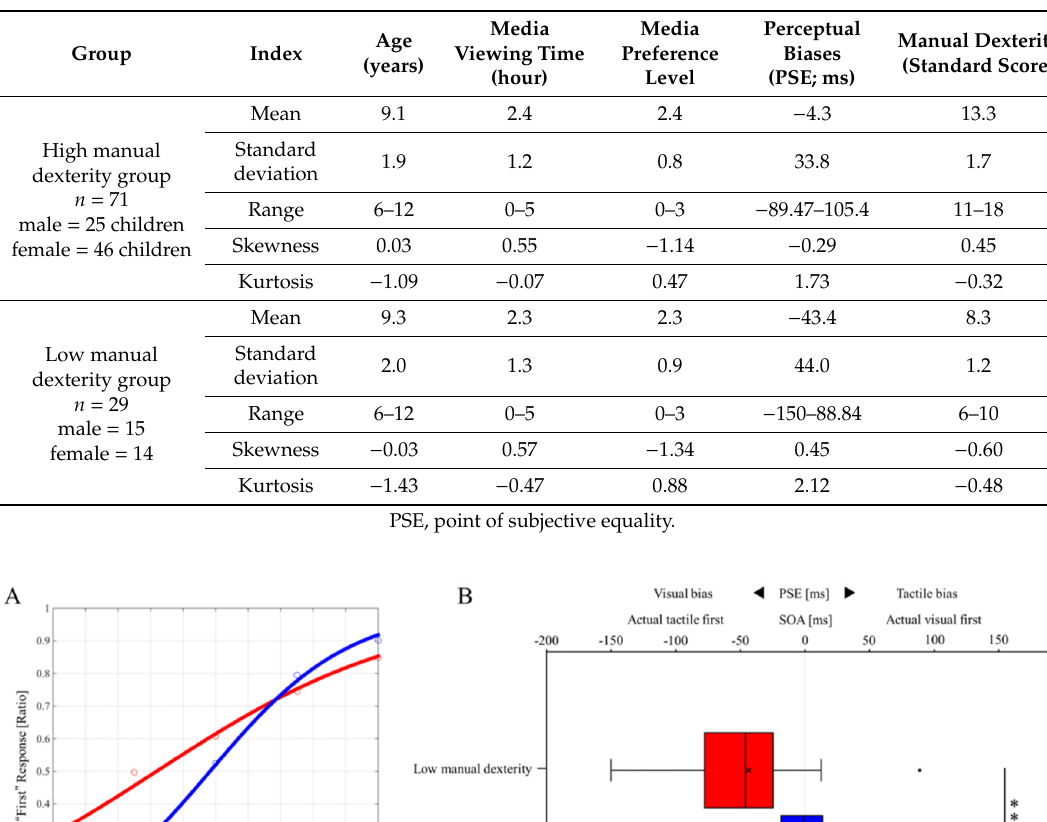
Table 5. Summary of data for each group.